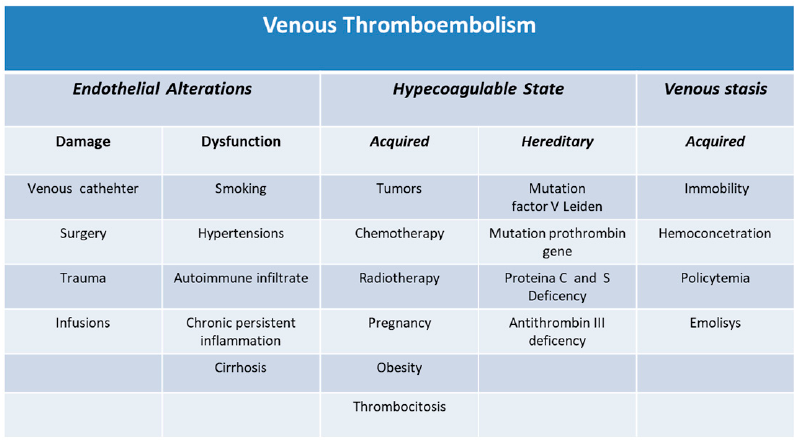
Figure 1. Classification of venous thromboembolism.